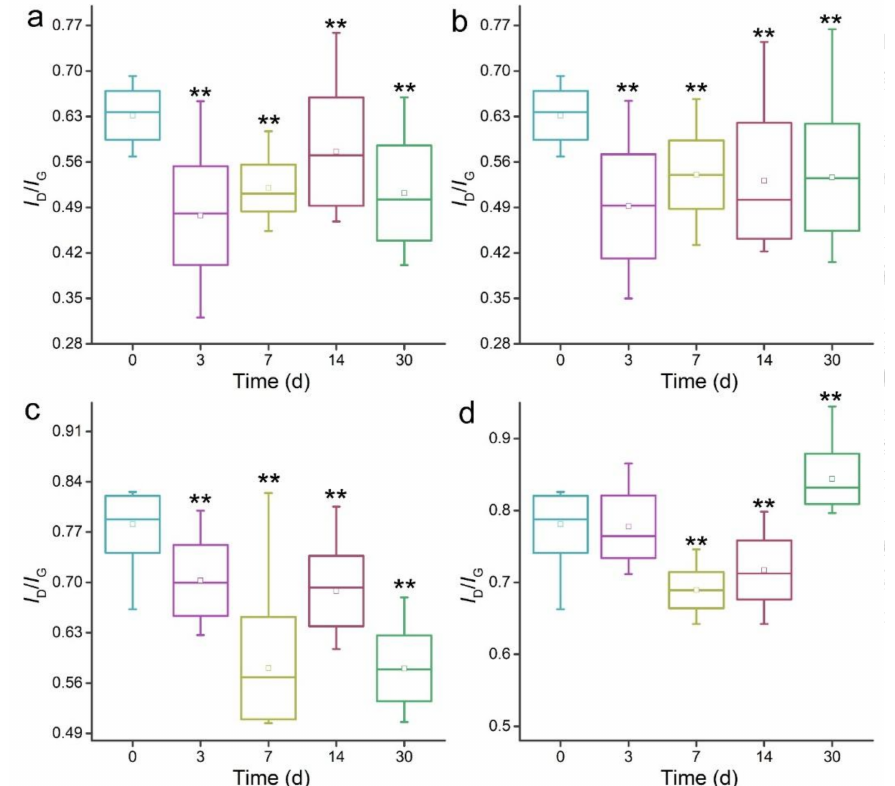
Figure 4. Raman spectra of MWCNTs after the incubation with P. chrysosporium . ( a ) Wrapped p-MWCNTs; ( b ) precipitated p-MWCNTs; ( c ) wrapped o-MWCNTs; ( d ) precipitated o-MWCNTs. Box-and-whisker plot shows the minimum and maximum (whisker bottom and top), first and third quartiles (box bottom and top), median (line inside box), and mean (square inside box) of I D / I G (intensity of D-band / intensity of G-band) values ( n = 20). ** p < 0.01 when compared to the 0 d